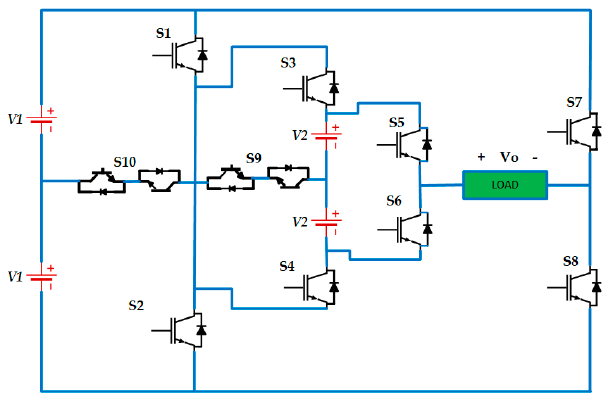
Figure 7. 25 − Level MLI.